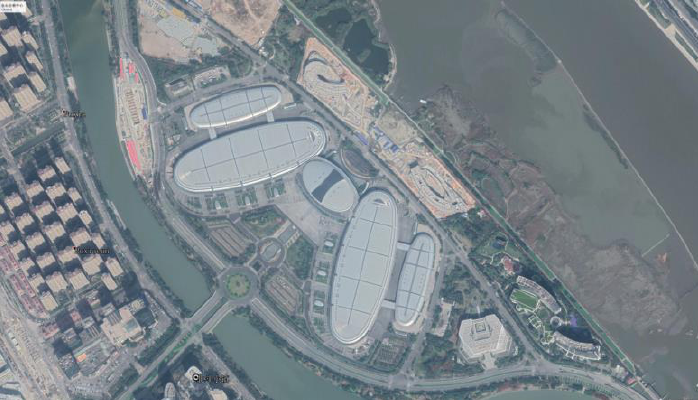
Figure 8. Remote-sensing image of Cangshan Convention and Exhibition Center.